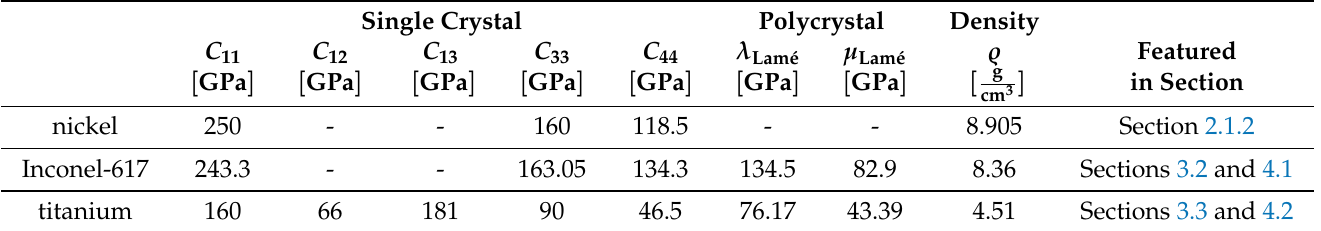
Table 1. Elastic constants of the three considered alloys. Nickel [13] and Inconel-617 [32] feature face centered cubic (fcc) single crystal structures and titanium [33] a hexagonally closely packed (hcp) one. The material specific density (cid:36) represents the material in both